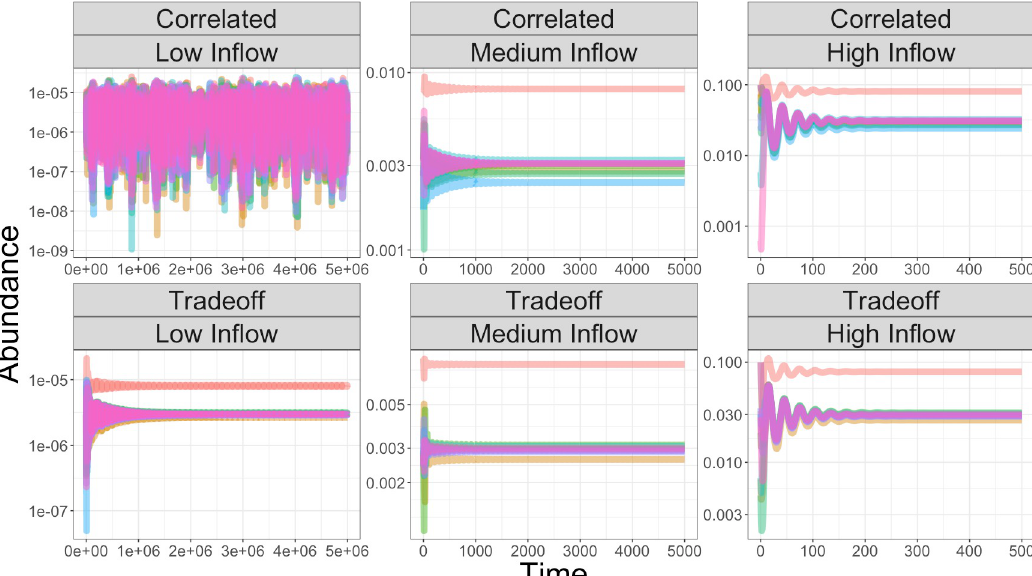
Fig 6. Stable and unstable consumer dynamics for varying resource inflows. We plot the consumer dynamics for two different consumption networks—one where the coefficients are sampled randomly from a distribution with correlations across the diagonal (labeled Correlated) and the other according to the tradeoff consumption network described in the text (labeled Tradeoff)—for three different magnitudes of one externally supplied resource (Low Inflow: ρ 1 = 0.001, Medium Inflow: ρ 1 = 0.1 and High Inflow: ρ 1 = 1). The S = 15 consumers’ growth rates are determined by the most limiting resources following Liebig’s law. All other resources are not supplied ( ρ i = 0 for i = 2, ... , S ). In each case, the production network is given by the constant parameterization where all other resources are produced from a given incoming resource. For the tradeoff network, the equilibrium is stable regardless of resource inflow levels, while the correlated network becomes unstable when the resource inflow is low. Parameters: S = 10, C η i = 1, θ = 0.9, � ii = 0.05 and � ij = 1 for i 6¼ j . Consumption coefficients sampled from uniform distributions on [0.5, 1.5] before the constraints are